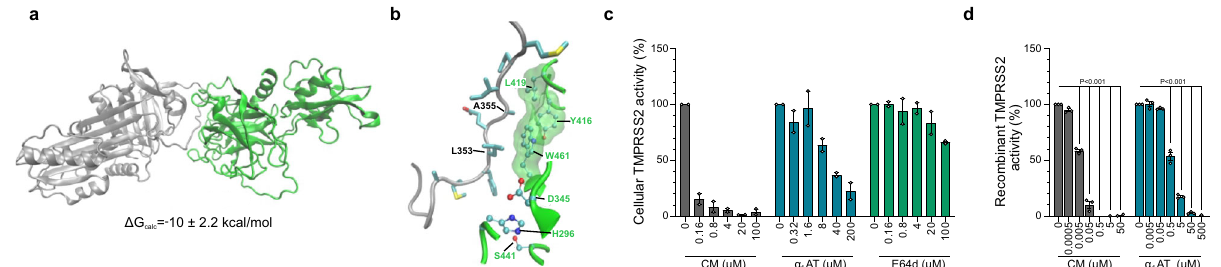
Fig. 5 α 1 AT binds the extracellular region of TMPRSS2 and inhibits TMPRSS2 protease activity. a Protein – protein docking analysis of a homology model for the TMPRSS2 extracellular fragment (green, PDB 1z8g) and α 1 AT (gray, PDB 3cwm) and computationally calculated binding free energy ( Δ G calc ) of the complex. b Detailed view on α 1 AT-TMPRSS2 binding interface. The sidechains of α 1 AT (gray) residues are represented with sticks, while sidechains of TMPRSS2 (green) are shown with balls and sticks. Hydrogen atoms are omitted for clarity, carbon, oxygen, nitrogen or sulfur atoms of amino acid side chains depicted in light blue, red, dark blue or yellow, respectively. The hydrophobic patch near the TMPRSS2 catalytic triad is highlighted with a green transparent surface. c α 1 AT inhibits cell-associated TMPRSS2 activity. HEK293T cells were transfected with a TMPRSS2 expression plasmid and treated with Prolastin ( α 1 AT, blue), camostat mesylate (CM, gray) or E-64d (green) followed by incubation with the fl uorogenic TMRPSS2 protease substrate BOC-Gln-Ala-Arg-AMC. Graph shows the relative area under the curve analysis of fl uorescence intensities over 2 h that were corrected by values for mock-transfected HEK293T cells. d α 1 AT inhibits recombinant TMPRSS2 enzyme activity. Recombinant human TMPRSS2 was mixed with Prolastin ( α 1 AT, blue) or CM (gray) prior to addition of fl uorogenic TMPRSS2 protease substrate BOC-Gln-Ala-Arg-AMC, graph shows relative fl uorescence intensities after 3 h of incubation. The mean ± SEM of n = 2 ( c ) or n = 3 ( d ) independent experiments in biological duplicates are shown (ordinary one-way ANOVA with Dunett´s multiple comparison test). Source data are provided as a Source data fi